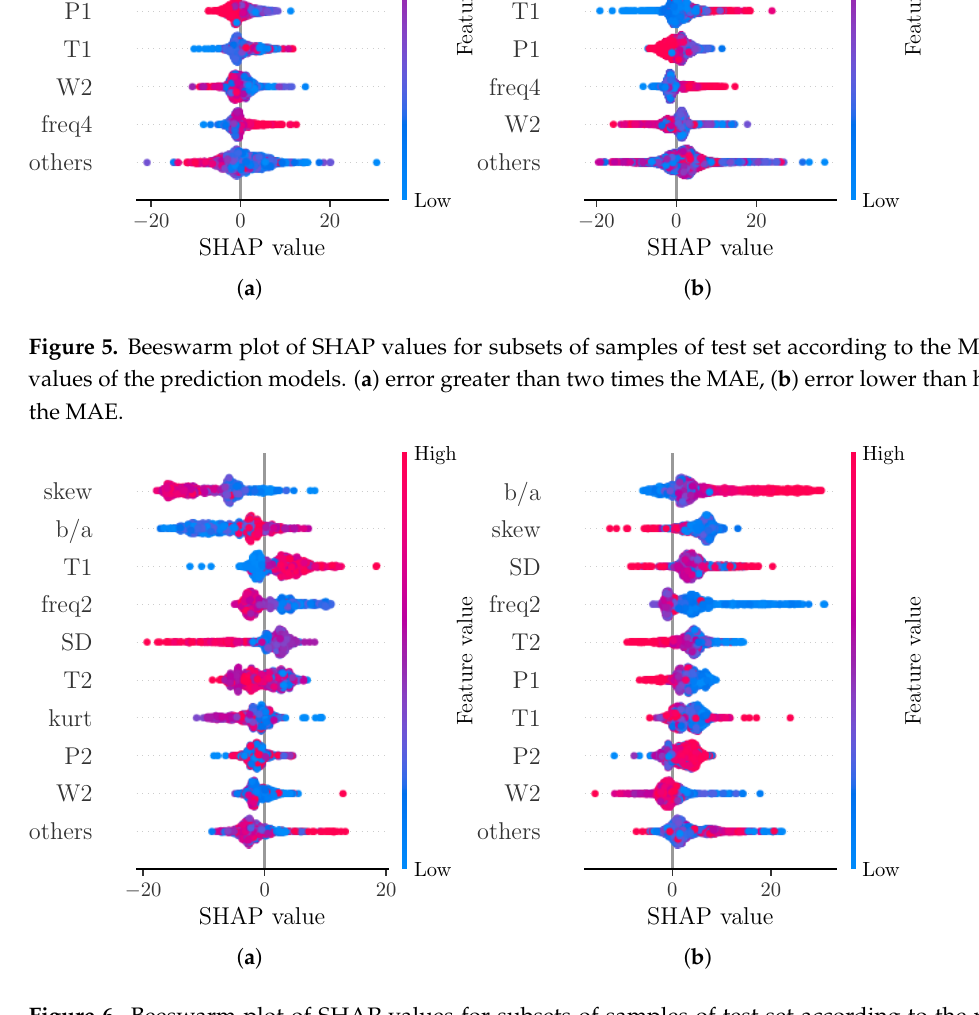
Figure 6. Beeswarm plot of SHAP values for subsets of samples of test set according to the pre- dicted SBP. ( a ) prediction lower than 0.8 times the mean prediction, ( b ) prediction greater than 1.2 times the mean